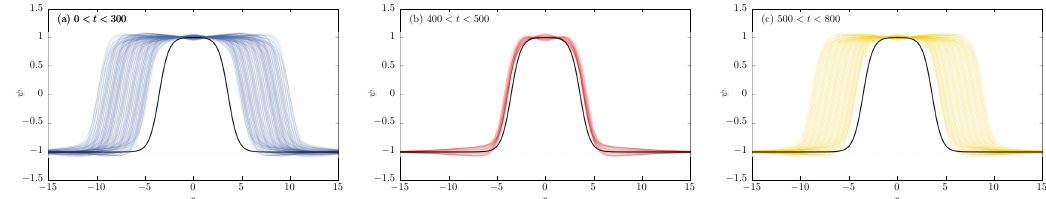
Figure 8 . Evolution of the field ψ obtained in the scattering of the initial configuration (5.1)–(5.2) with the pink mode ( n = 8) initially excited. Here A = 0 . 085 and solitons are back scattered before the